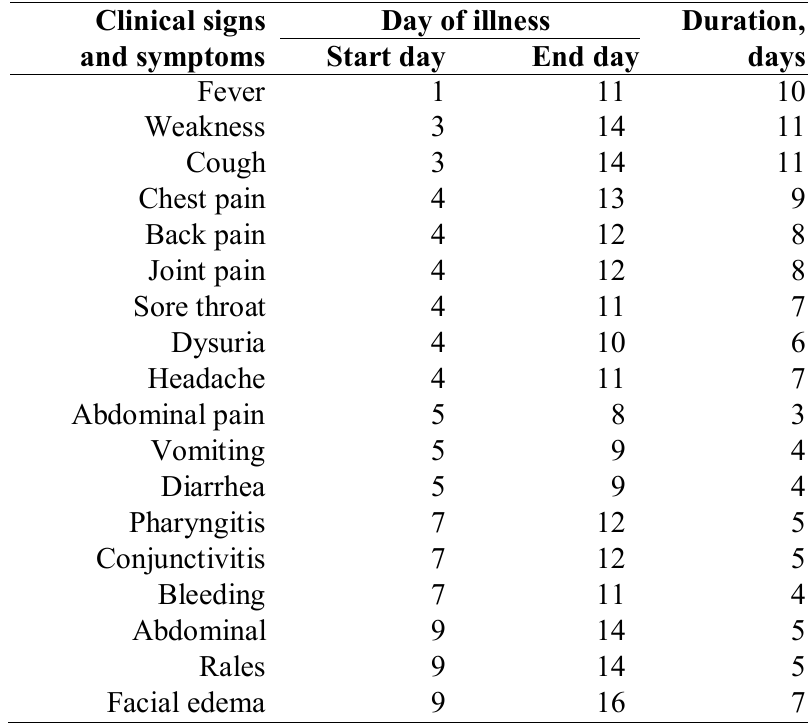
Table 2 . Onset and duration of the principal clinical manifestations of Lassa fever (adapted from reference